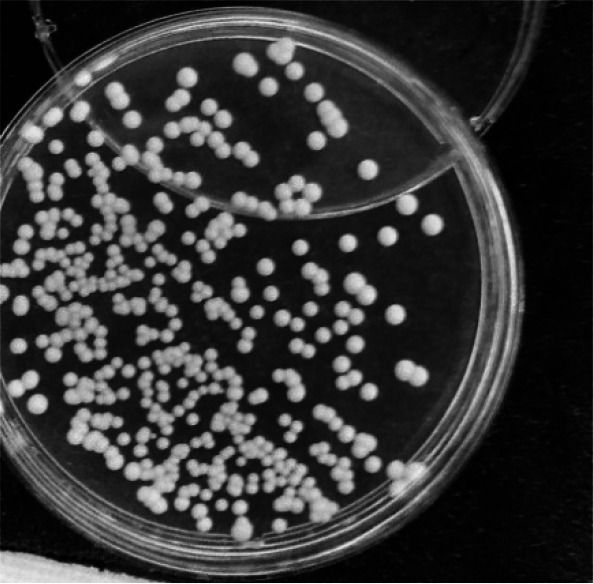

Candida albicans colony forming units before treatment with ZM